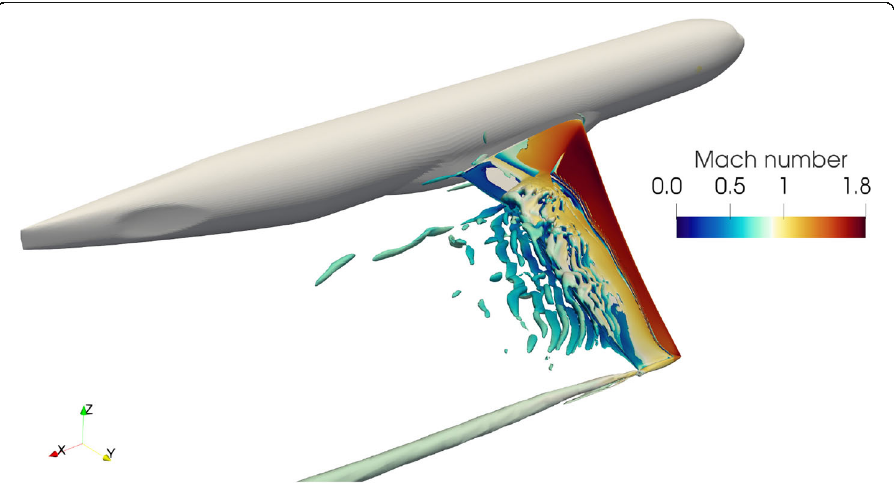
Fig. 16 Instantaneous isosurface of Q = 50,000 at t = 1.2 s. Flow conditions M = 0.85, Re = 5 m, α =